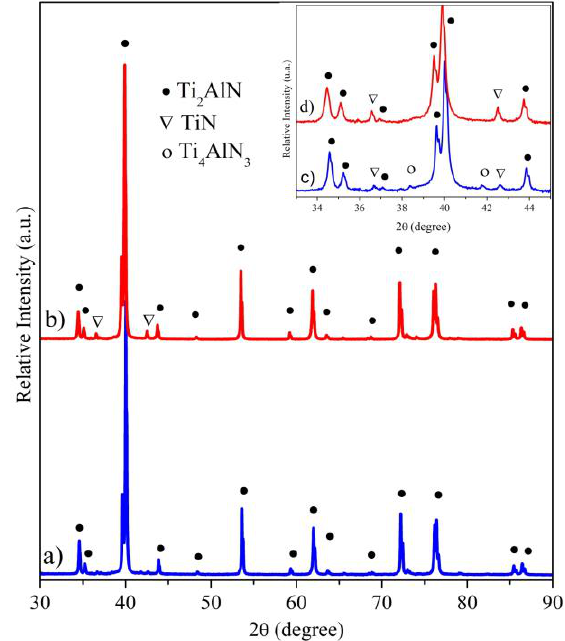
Figure 2. XRD patterns of the bulk Ti 2 AlN MAX phase samples: ( a ) MAX-1200 (blue pattern) and ( b ) MAX-1300 (red pattern). A zoom of the XRD patterns between 2 θ = 33 ◦ and 45 ◦ for ( c ) MAX-1200 and ( d ) MAX-1300.